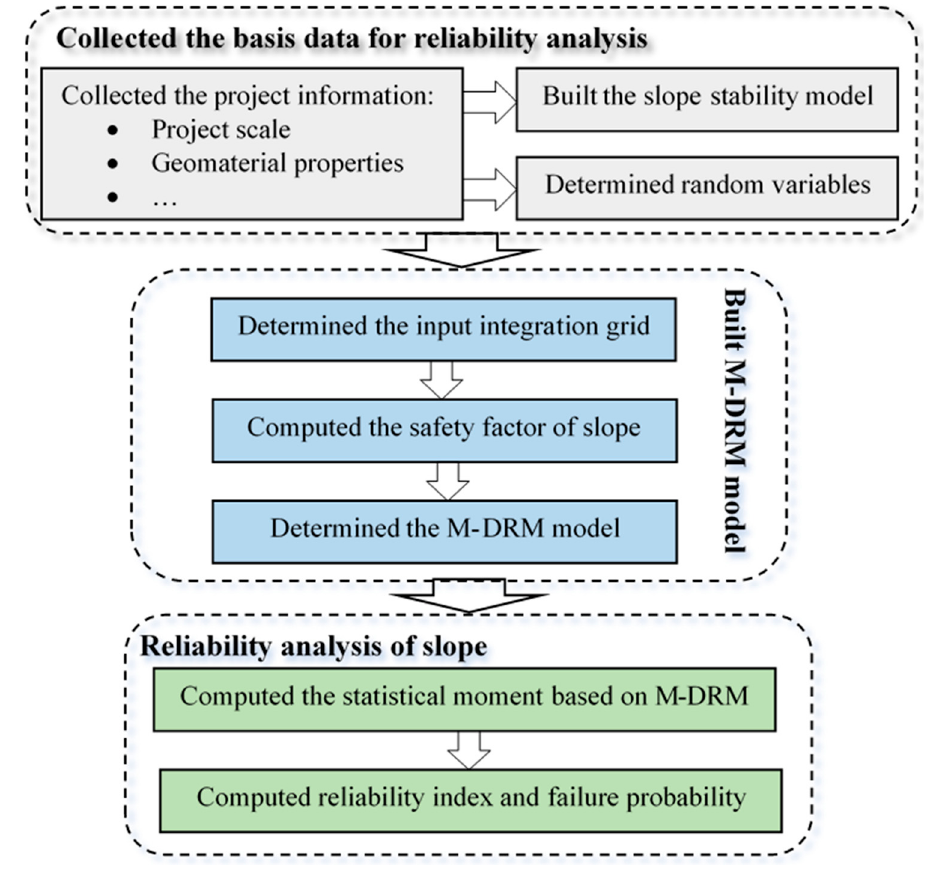
Figure 1. The reliability analysis of slope based on MDRM.